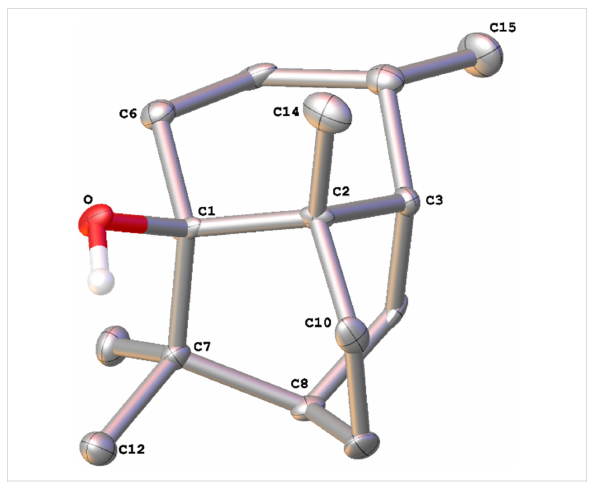
Figure 2: ORTEP representation of patchoulol ( 3 ). Cu K α , Flack parameter: − 0.1(2); P2(true) = 1.000, P3(false) = 0.6·10 − 5